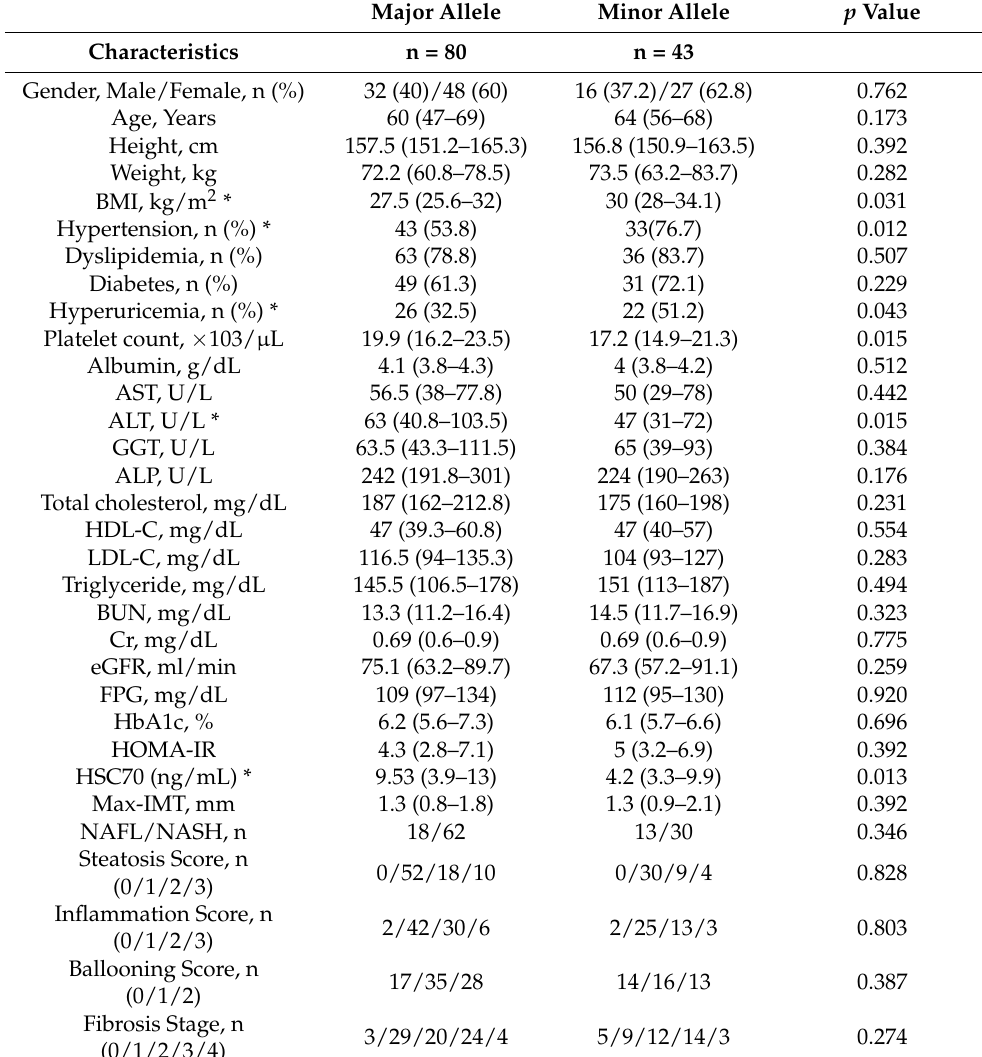
Table 1. Characteristics of patients according to presence of HSPA8